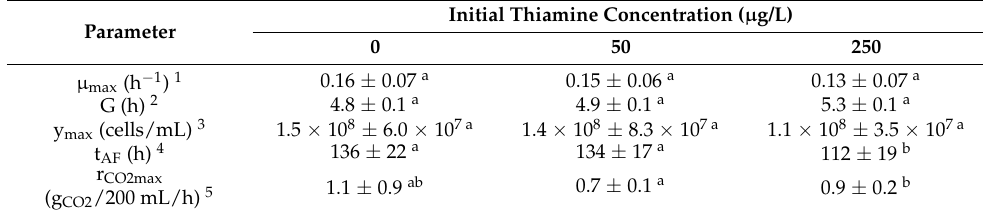
Table 3. Initial thiamine impact on the growth and fermentation kinetics.